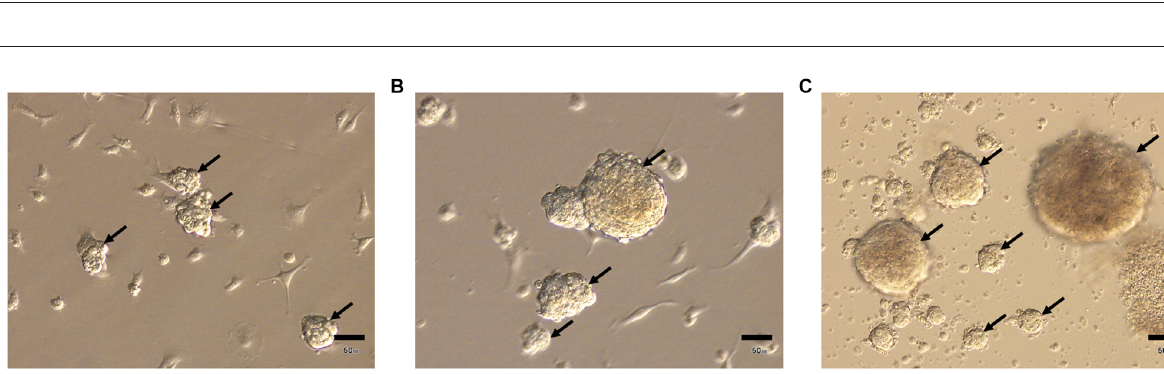
potential of obtained ADSCs cultures meet the minimal criteria for defining multipotent mesenchymal stromal cells according to the International Society for Cellular Therapy (ISCT) position statement (Dominici et al.,